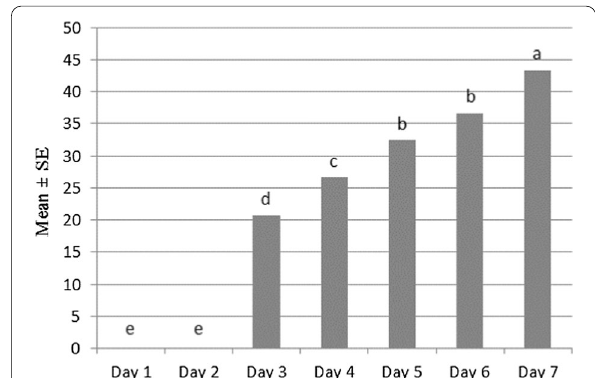
Fig. 3 Mortality of Locusta migratoria migratorioides during 7 Days after treatment with Photorhabdus luminescens (EGAP3). Bars (mean SE in the same and between time intervals with the same ± letter(s) are not significantly different ( P < 0.005)